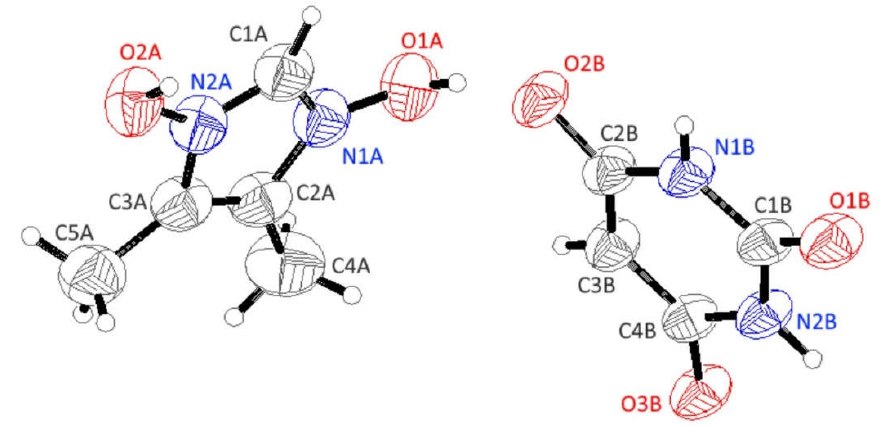
Figure 14. Ortep drawing of the independent unit in BA/HIMO cocrystal.